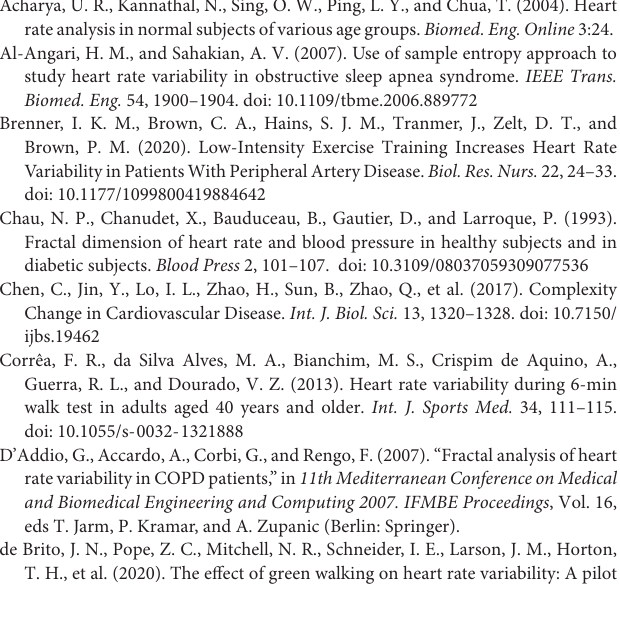
Figure 3-3 (2019). Shimmer-ECG-heart-measurements . Ireland: Realtime Technologies Ltd. Available Online at: